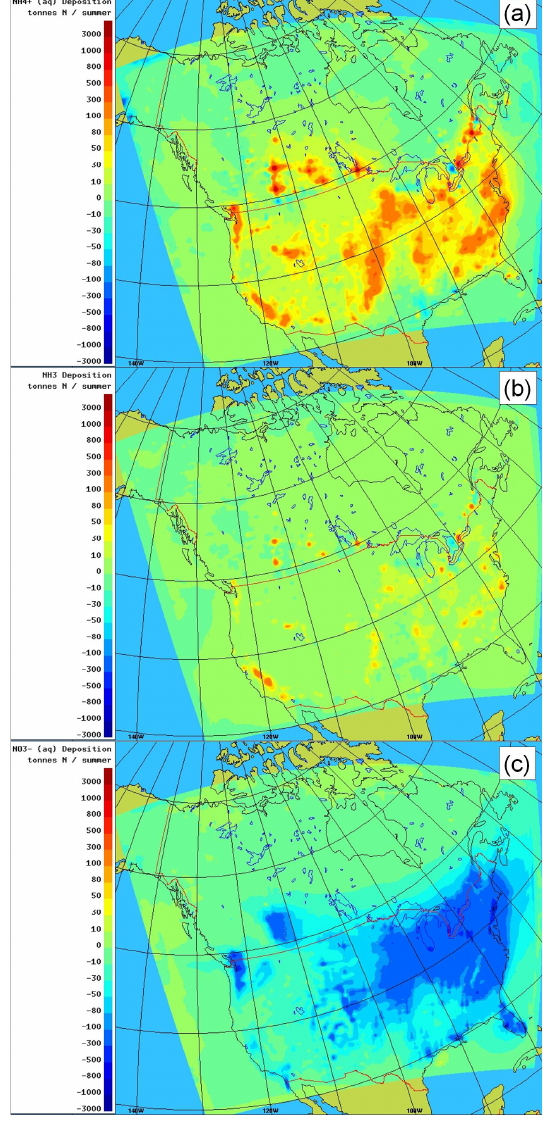
Fig. 17. Three main contributors to changes in N deposition 1 CE, tonnes/summer. (a) Wet deposition of NH + of gaseous NH 3 . (c) Wet deposition of NO − and negative scales have a logarithmic